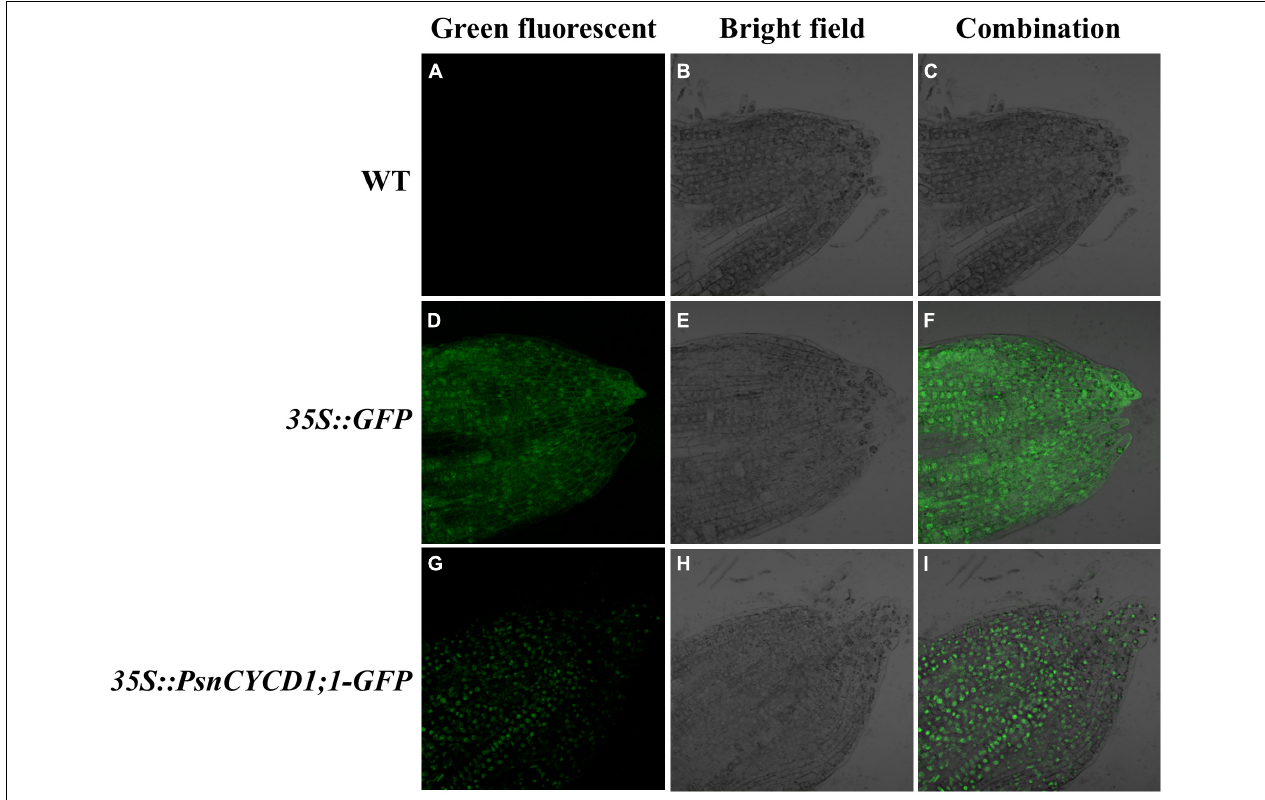
FIGURE 1 | Subcellular location of green fluorescent protein (GFP) and PsnCYCD1;1-GFP protein in tobacco root tip. Green fluorescent (A,D,G) : green fluorescence signal; bright field (B,E,H) : white light; and combination (C,F,I) : combined signals of different fluorescence. WT, wild-type; 35::GFP , pROKII- GFP , empty vector control; 35S::PsnCYCD1;1-GFP , fusion vector of pROKII- PsnCYCD1;1-GFP .